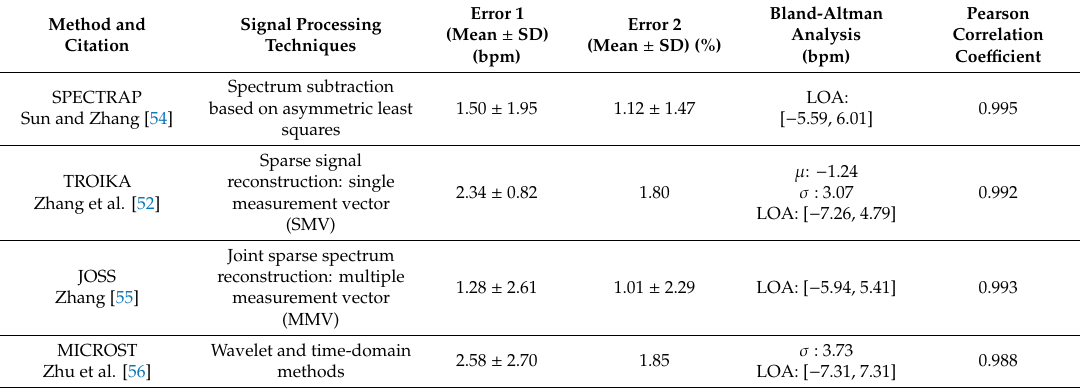
Table 4. Summary of wrist-type PPG techniques for HR monitoring, part